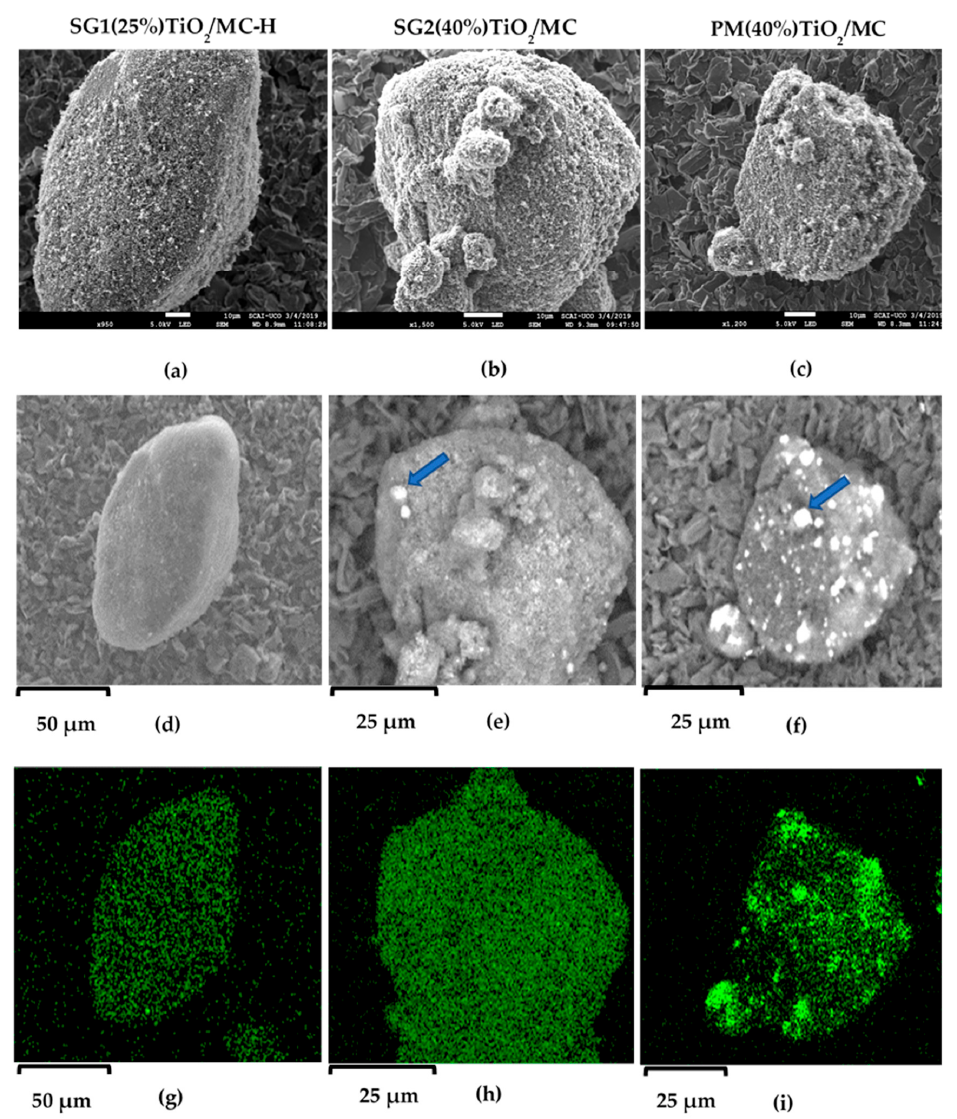
Figure 1. Secondary electron detector (SEM), backscattered electron (BSE), and Energy-dispersive X-ray spectroscopy (EDS) micrographs for three solids representative of each synthetic method: SG1(25%)TiO 2 / MC-H, SG2(40%)TiO 2 / MC, and PM(40%)TiO 2 / MC. ( a ) 5 kV × 950; ( b ) 5 kV × 1500; ( c ) 5 kV × 1200; BSE ( d – f ); EDS mapping obtained for the Ti K α 1 signal ( g – i ).